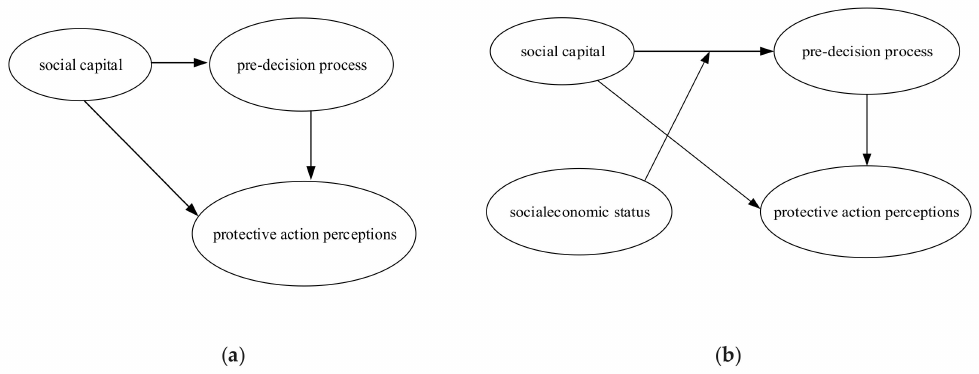
Figure 2. Influence paths of social capital: ( a ) three factor model; ( b ) four factor